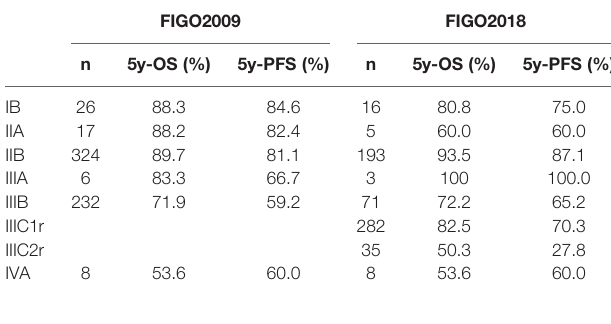
TABLE 2 | Overall survival and progression-free survival according to FIGO staging system. FIGO2009 FIGO2018